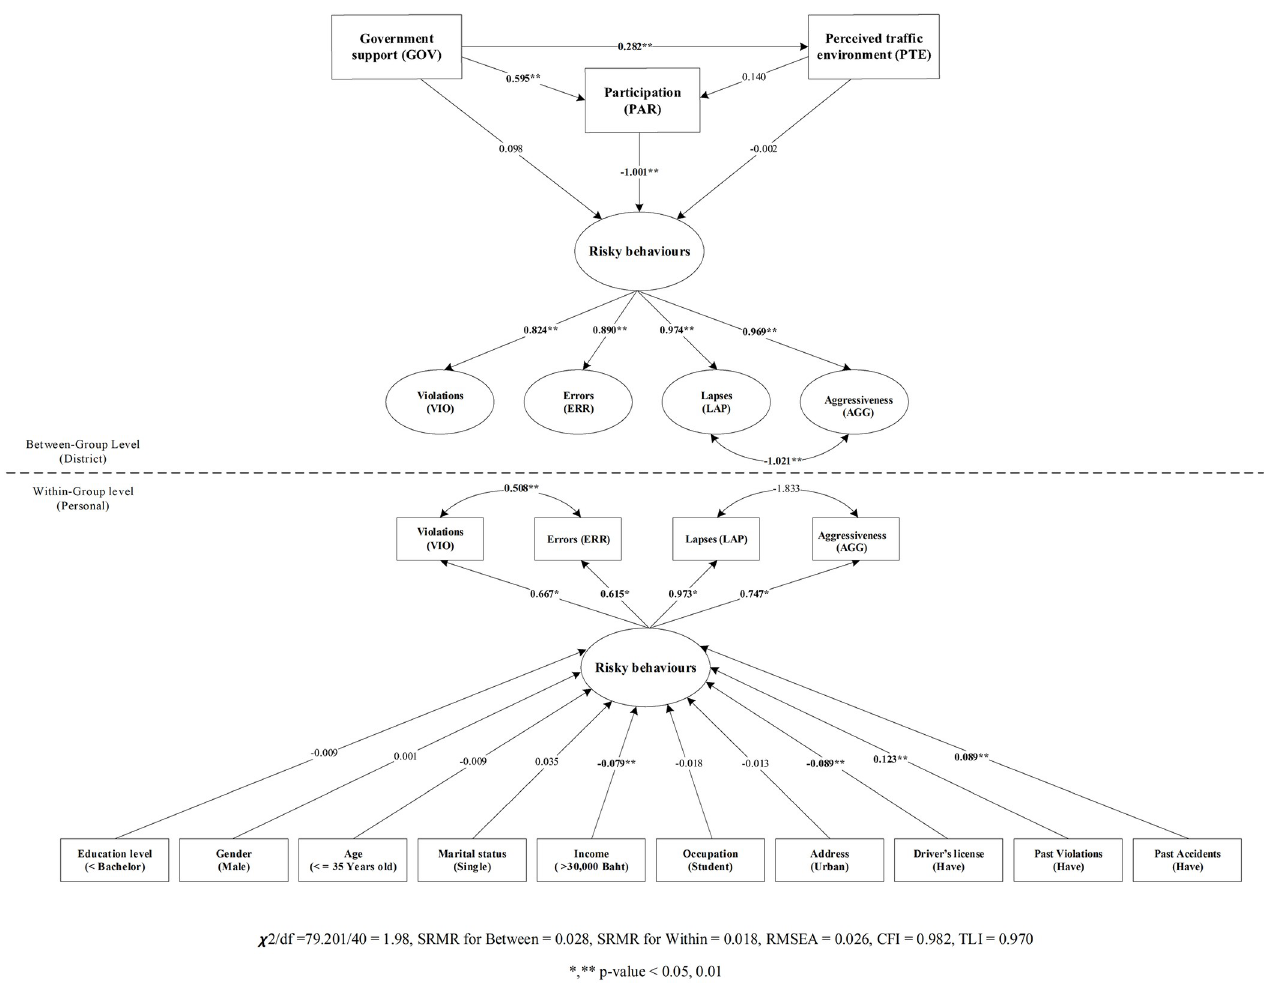
Fig 4. Risky behaviours modified model